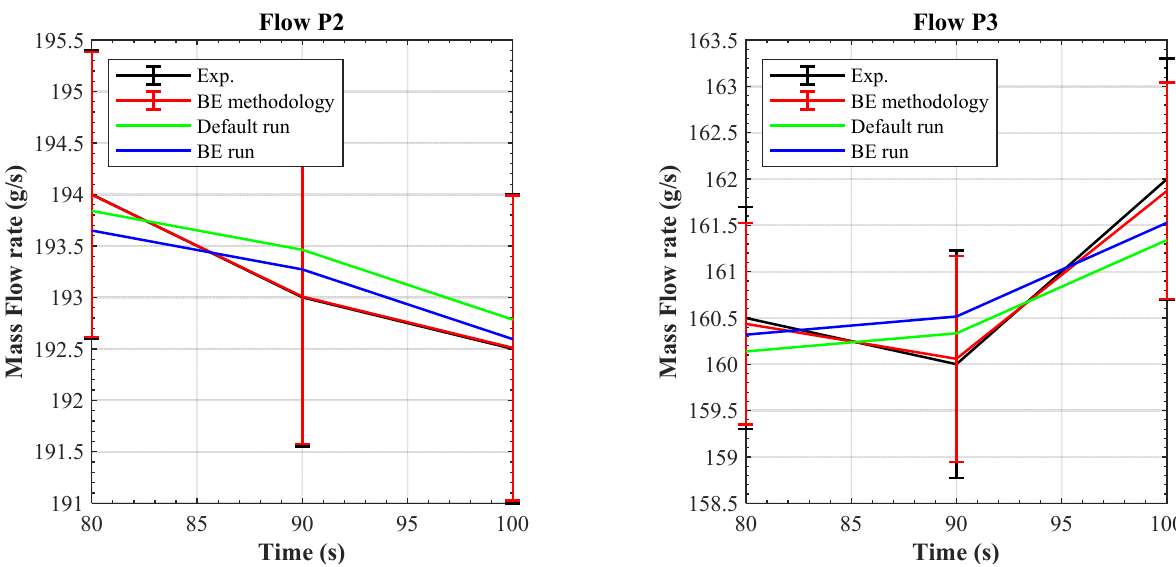
Figure 4. Results of the TPE test case (RELAP5-3D code).